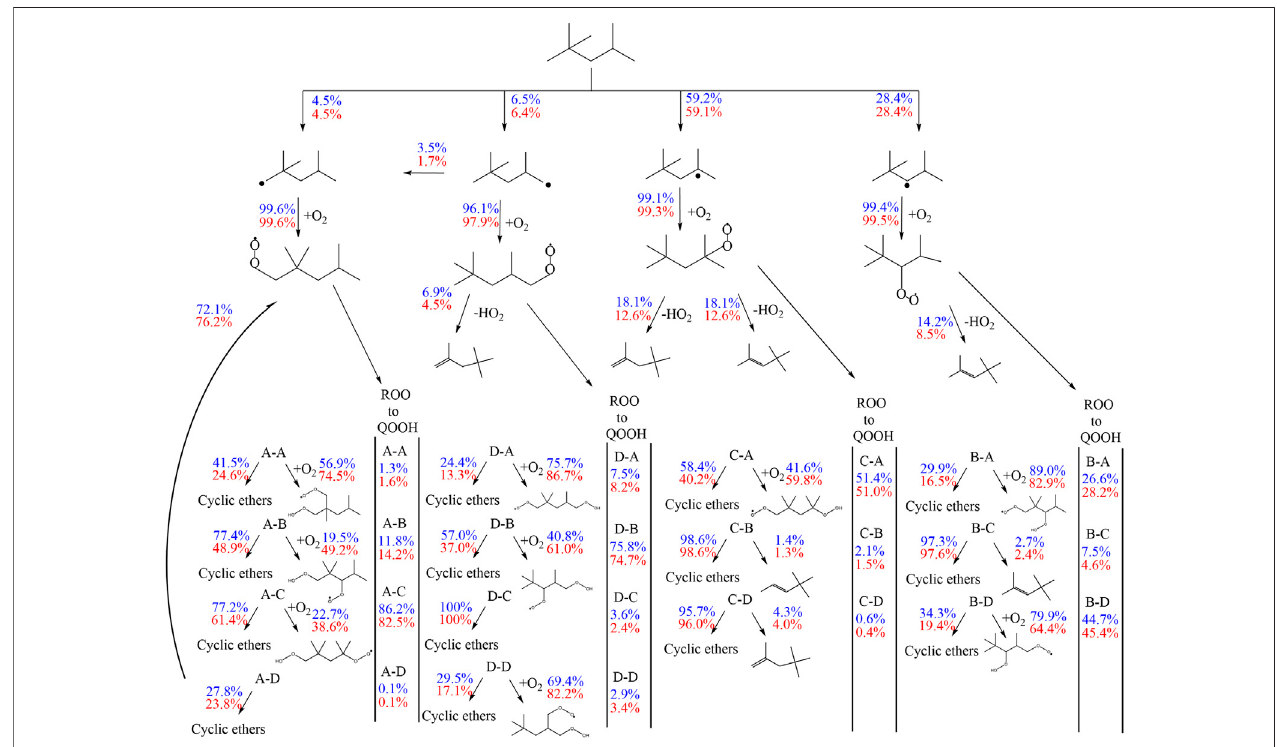
FIGURE 10 | Flux analysis performed with the model of Cai et al. (2019) at 10 (blue) and 20 bar (red), 623 K at 25% of the maximum achieved conversion of iso- octane at the speci fi c condition.